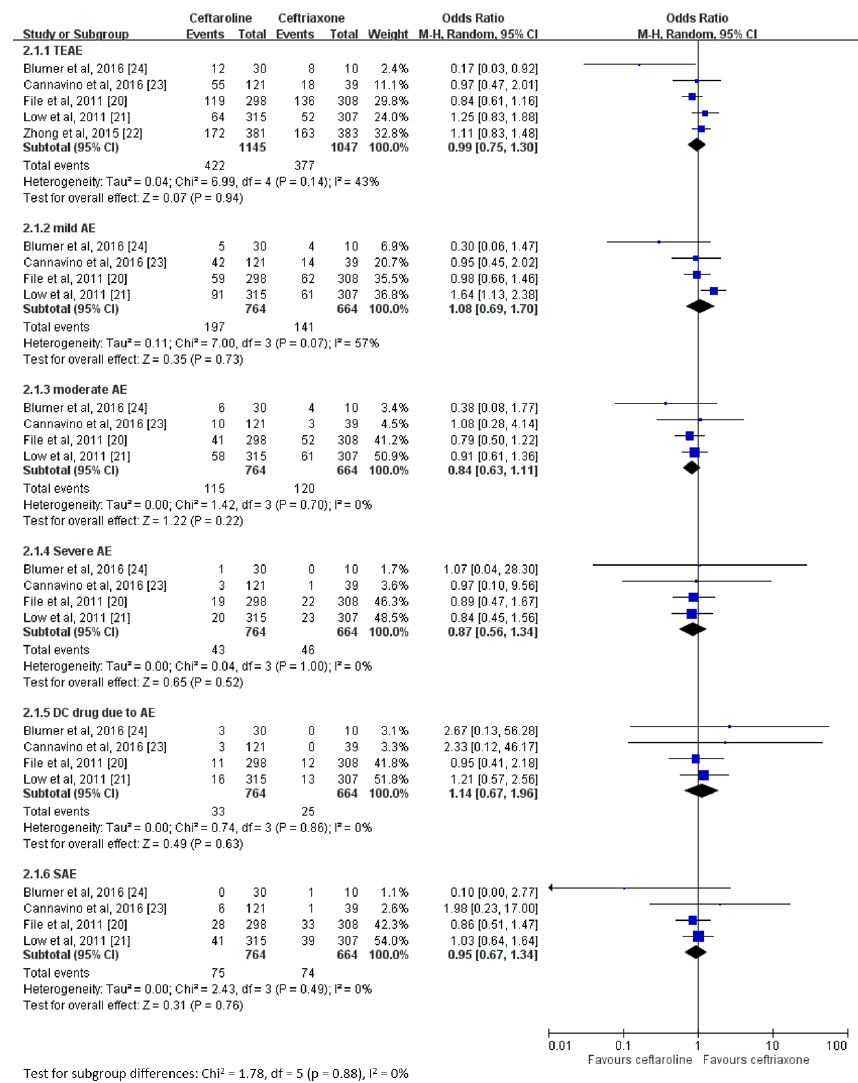
Figure 6. Risk of adverse events between ceftaroline and ceftriaxone for the treatment of community- acquired pneumonia.